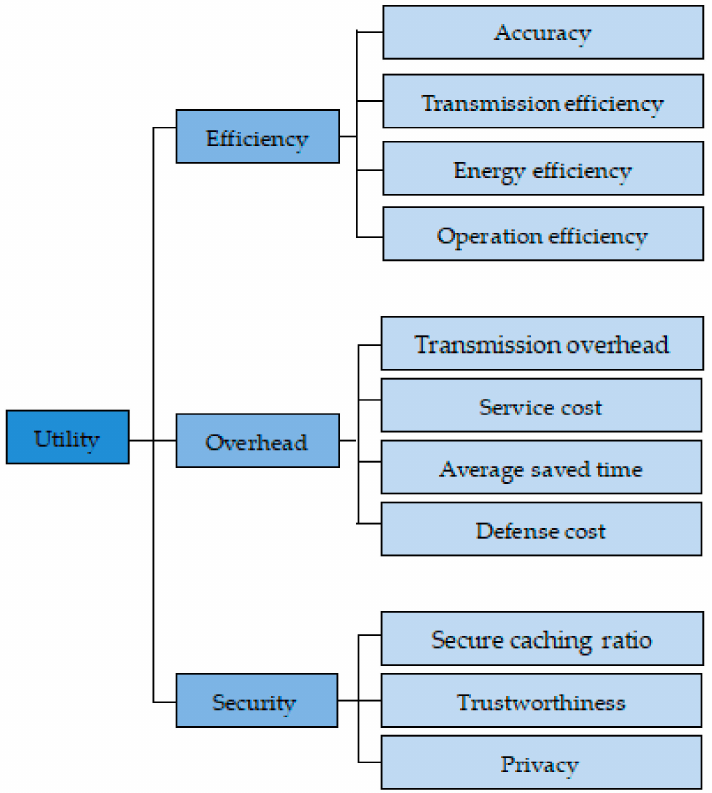
Figure 2. Some performance metrics related to